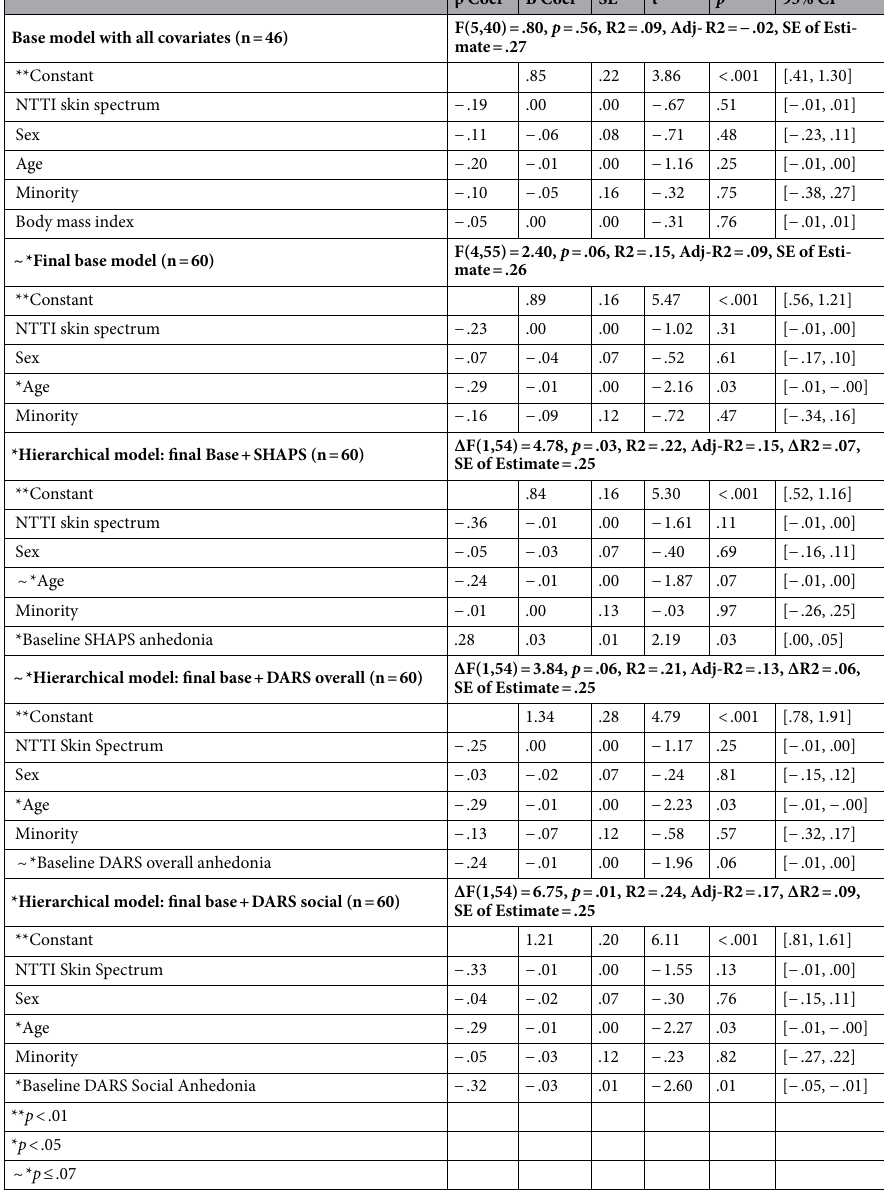
Table 3. Concurrent associations between anhedonia measures and PI− MED